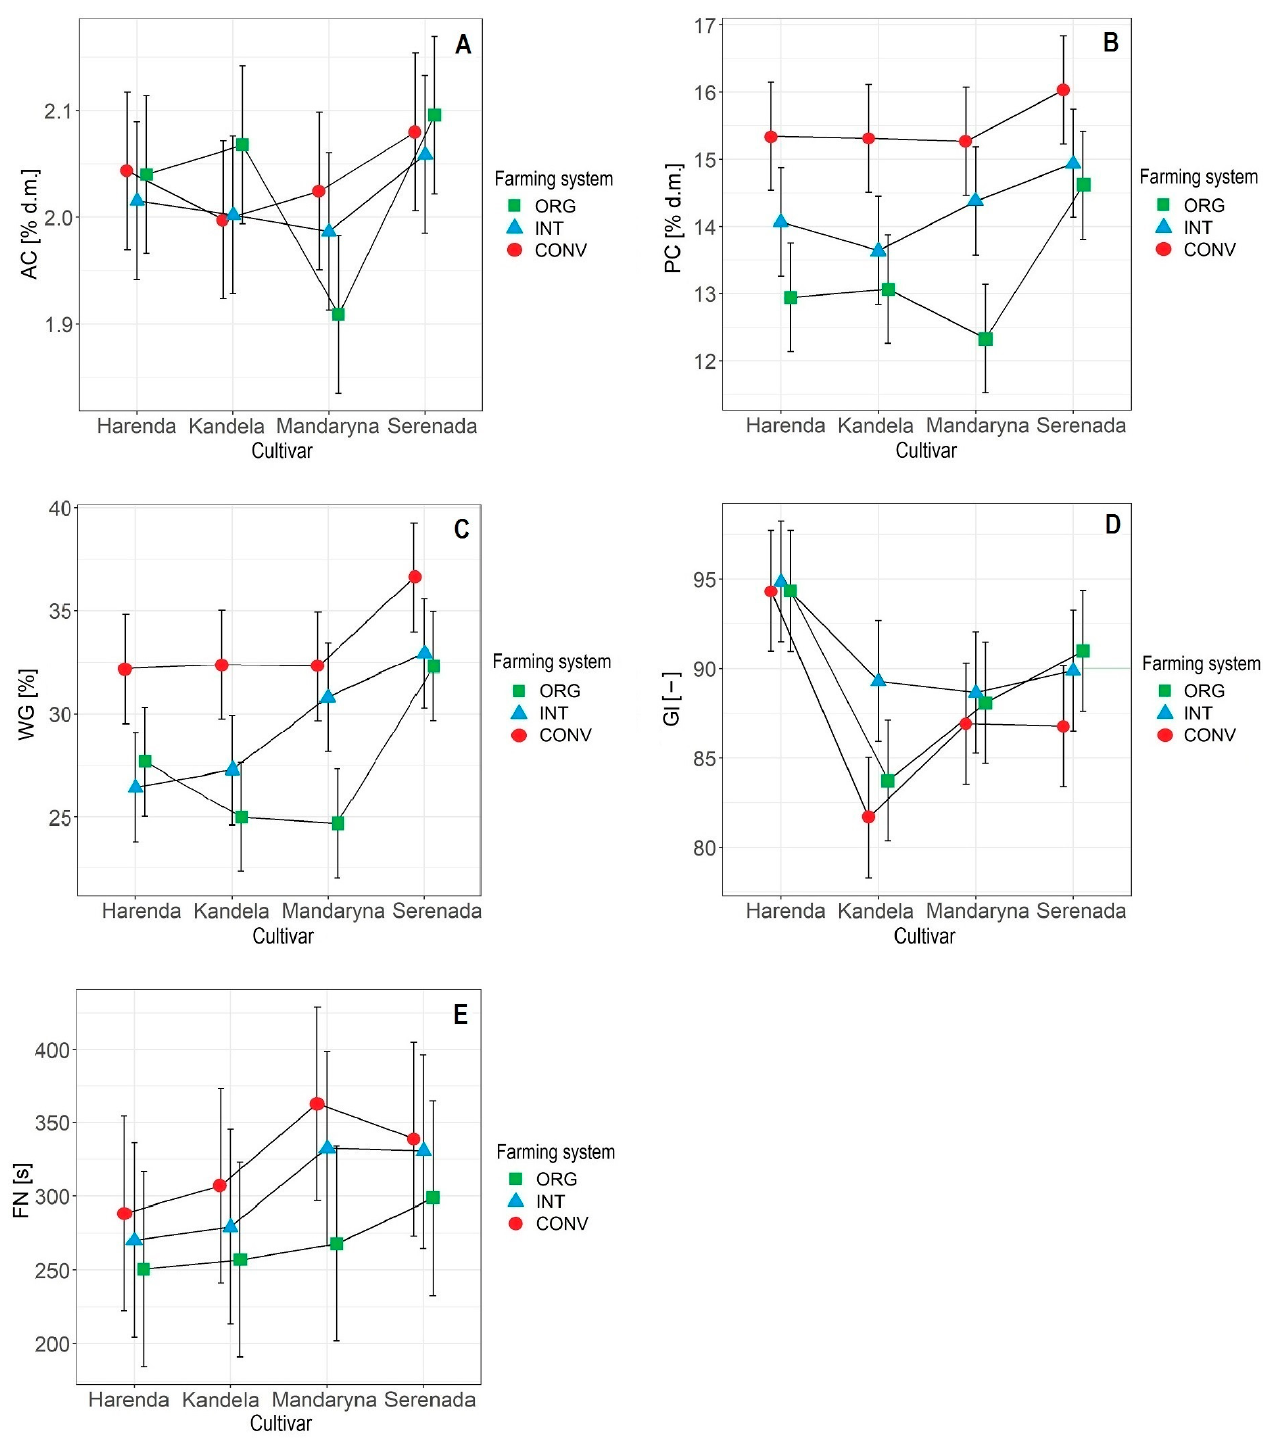
Figure 4. The interaction effects of cultivar and farming system on the chemical and rheological properties of wheat grain. Abbreviations: ( A ) AC—ash content, ( B ) PC—protein content, ( C ) WG— wet gluten, ( D ) GI—gluten index, ( E ) FN—falling number, ORG—organic, INT—integrated, and CONV—conventional.